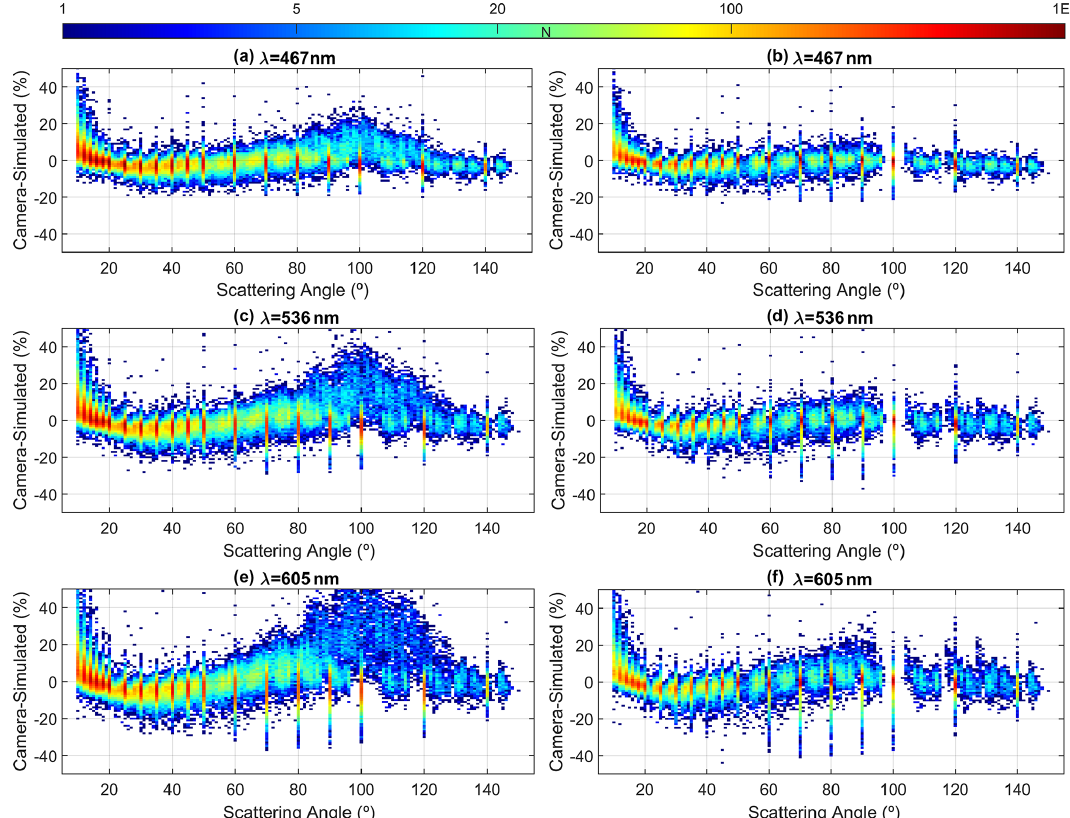
Figure 14. Relative differences between the camera and simulated normalized radiances as a function of the scattering angle for 467nm (a, b) , 536nm (c, d) and 605nm (e, f) . Left panels show the differences calculated without radiances under scattering angles below 10 ◦ , while right panels show the same differences but also obtained without radiances under zenith angles between 48 and 65 ◦